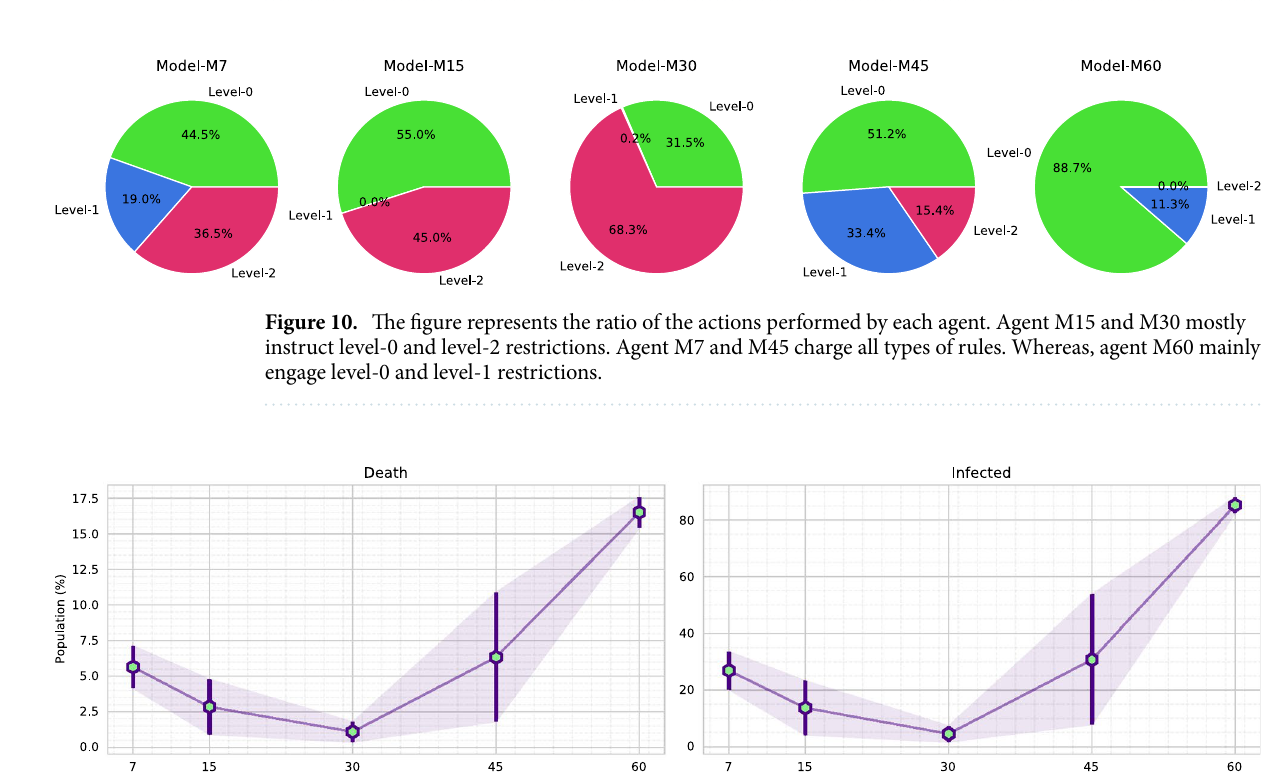
Figure 9. The figure illustrates the loss (upper) and reward (lower) comparison of the agents while training. Each of the agents was evaluated after 250 episodes. A single evaluation is presented as a mean of ten runs, and it is guaranteed that every model is tested on the same environment scenario. The M30 agent was trained for 7000 episodes. The M7, M15, M45, and M60 agents were initialized with the M30 agent’s trained weights. Therefore, these agents converged to an optimal state within 3000 episodes.